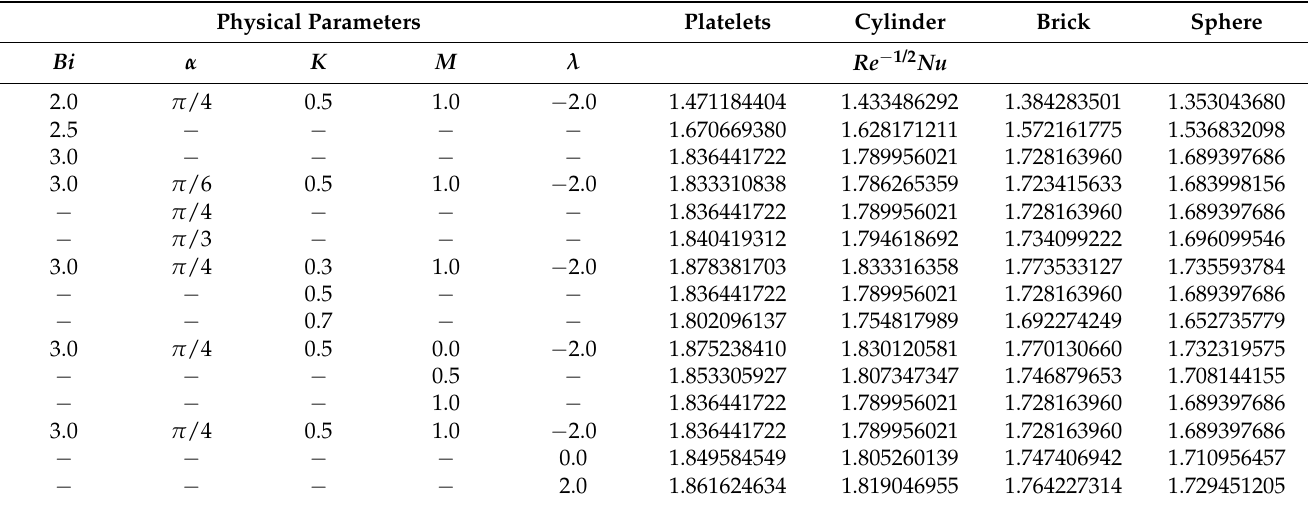
Table 5. Numerical values of Nusselt number for multi-shape